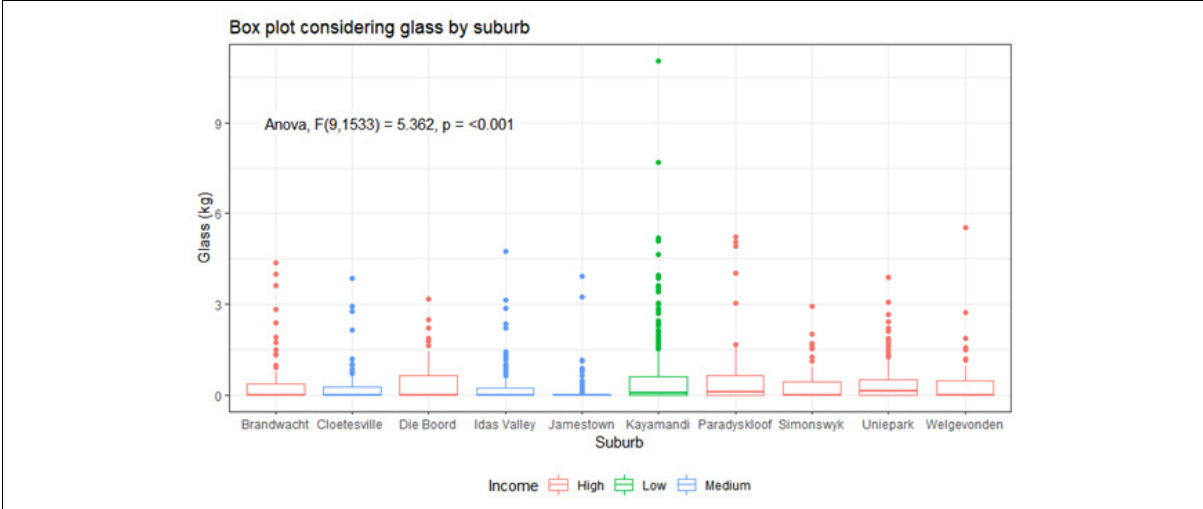
Figure 4: Box plot considering differences in mean glass composition of household solid waste among suburbs in